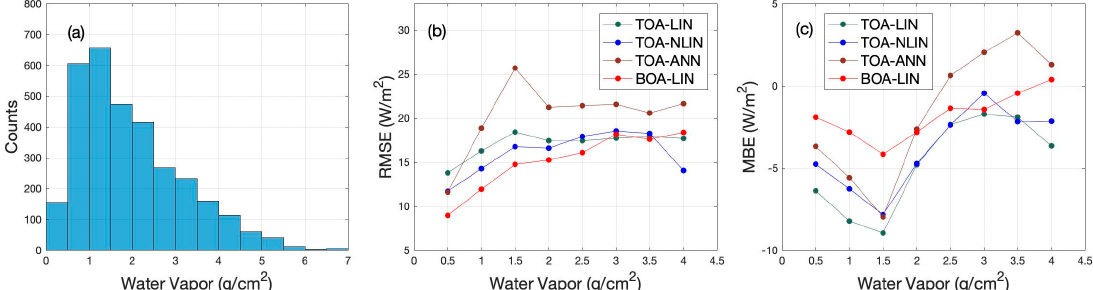
Figure 8. The comparison of four hybrid methods. ( a ) The wv histogram of the clear-sky observations. ( b ) The RMSE comparison of four hybrid methods at different wv. ( c ) The MBE comparison of four hybrid methods at different wv.